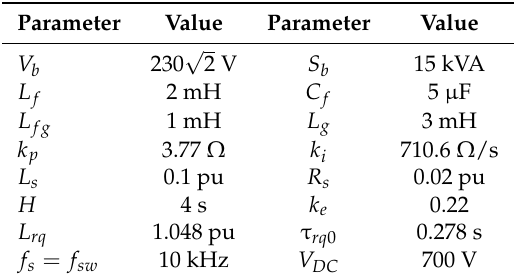
Table 2. Inverter and S-VSC parameters for the state-space model and of the experimental